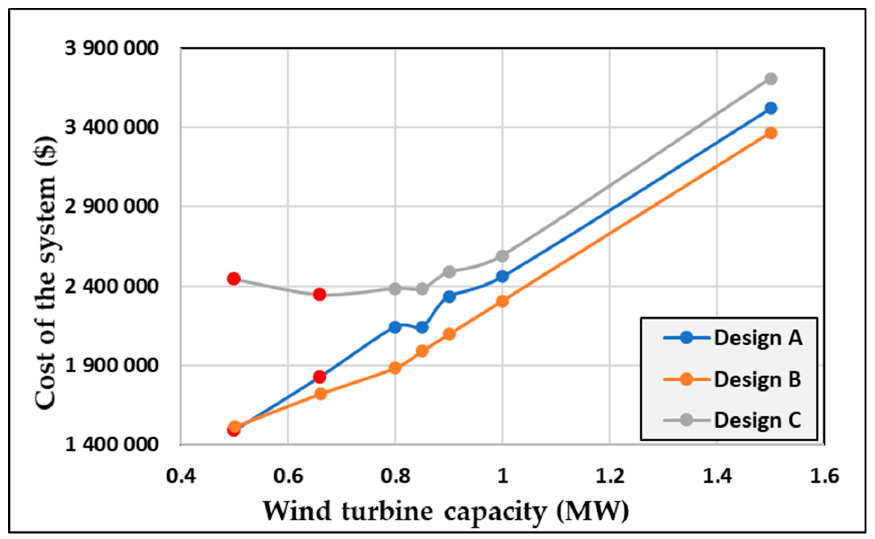
Figure 9. Comparison of the o ff -grid system for design A, B, and Figure 9 . Comparison of the off-grid system for design A, B, and C .